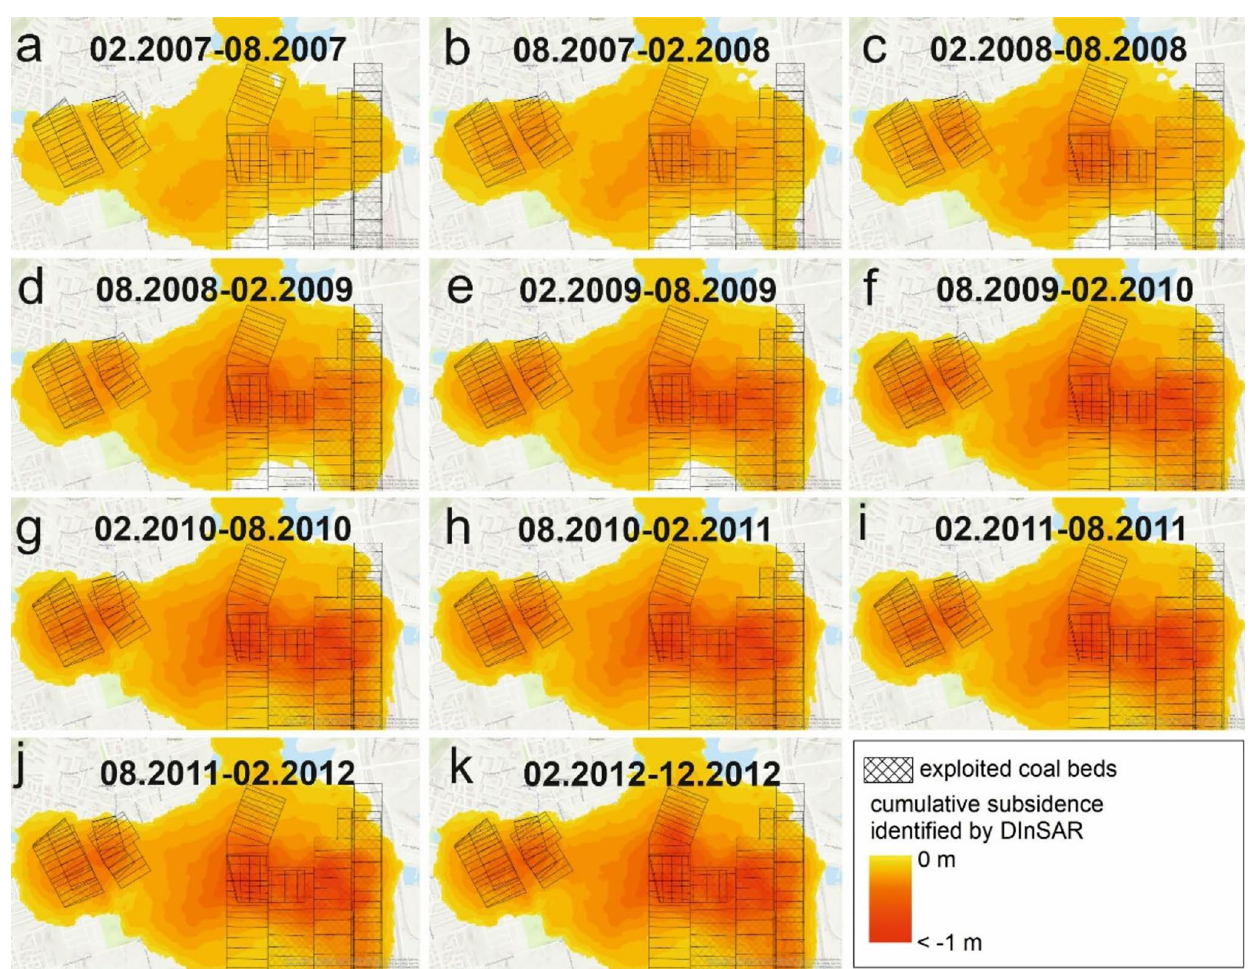
Fig. 5 Cumulative subsidence based on DinSAR surfaces from February 2007 to December 2012 with a six-month interval, with the ranges